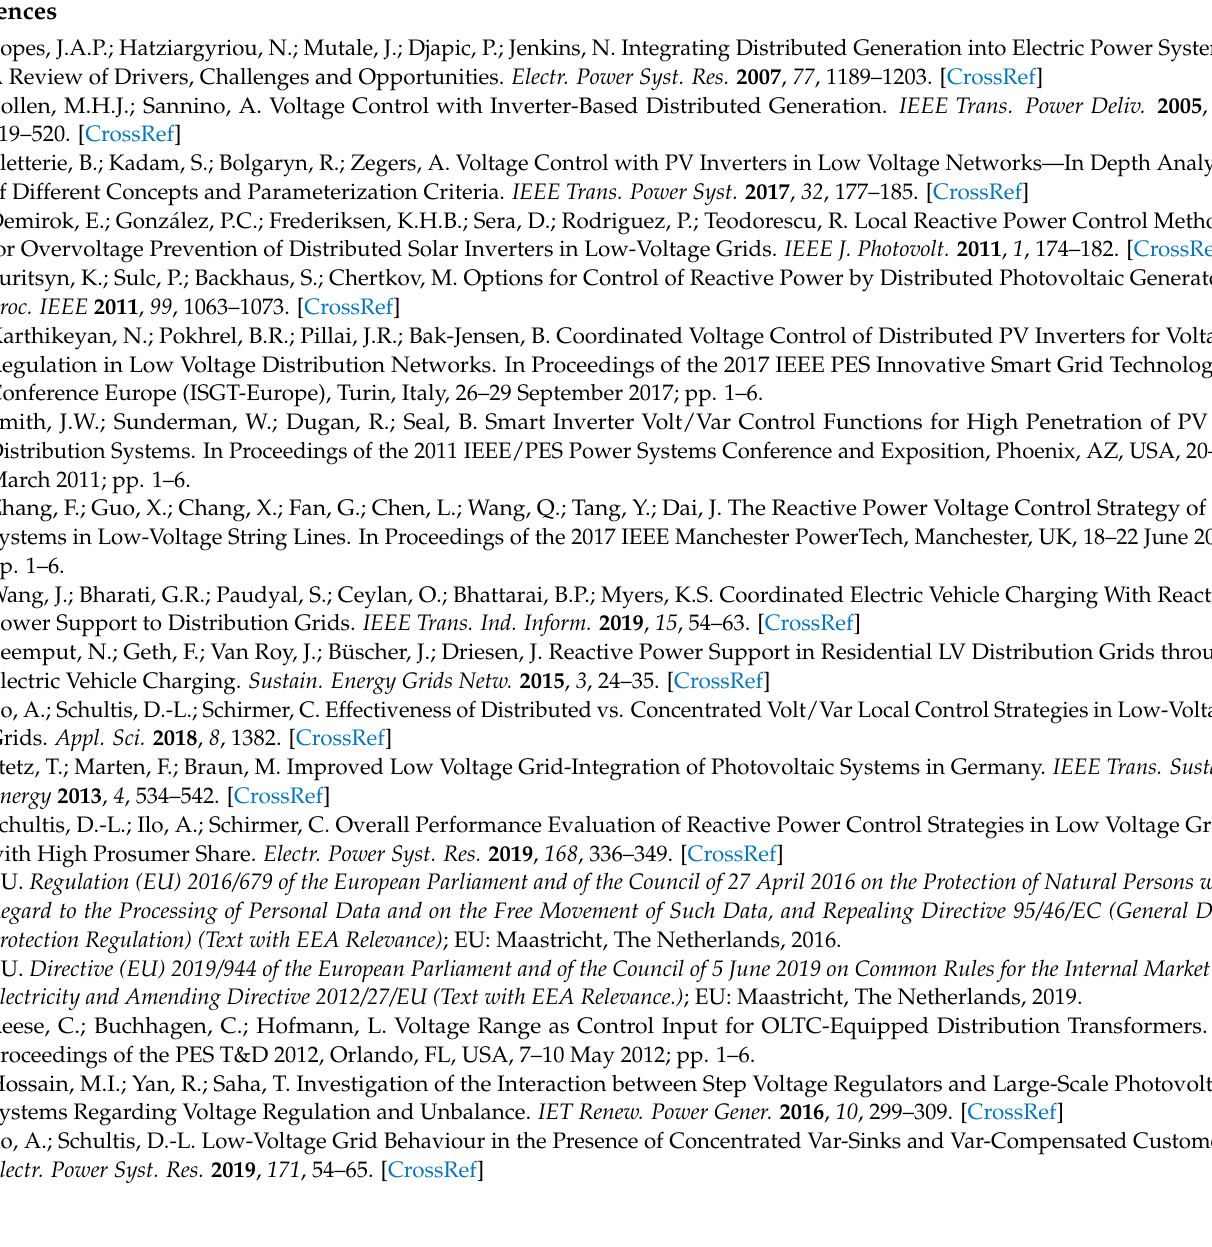
Figure A2. Industrial CP_Link-Grid: ( a ) structure; ( b ) load profiles of the Dev.-model; ( c ) production profile of the Pr.-model.